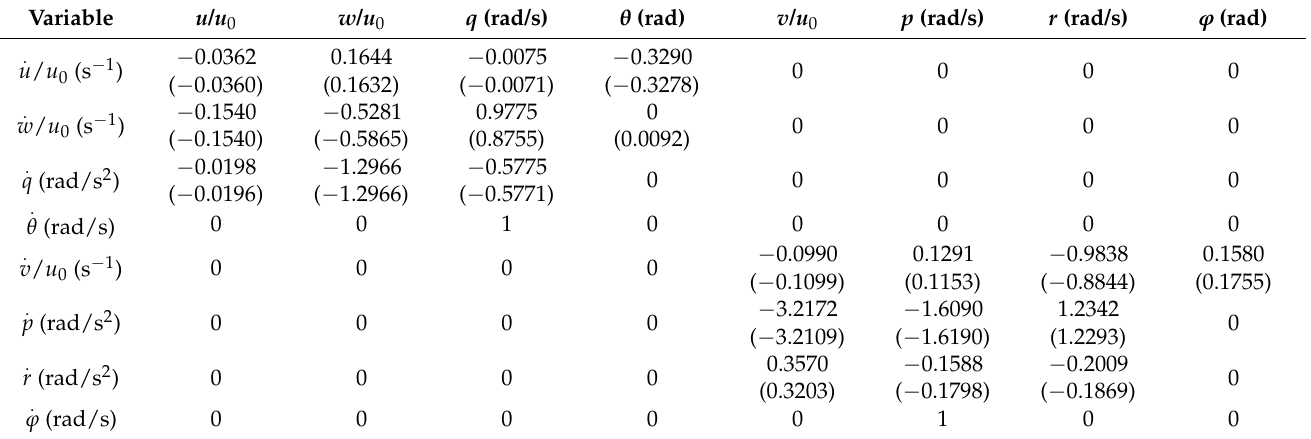
Table 11. CFD–RANS (extrapolated) 8 × 8 stability matrix for flight condition 4 in Tables 4 and 5.